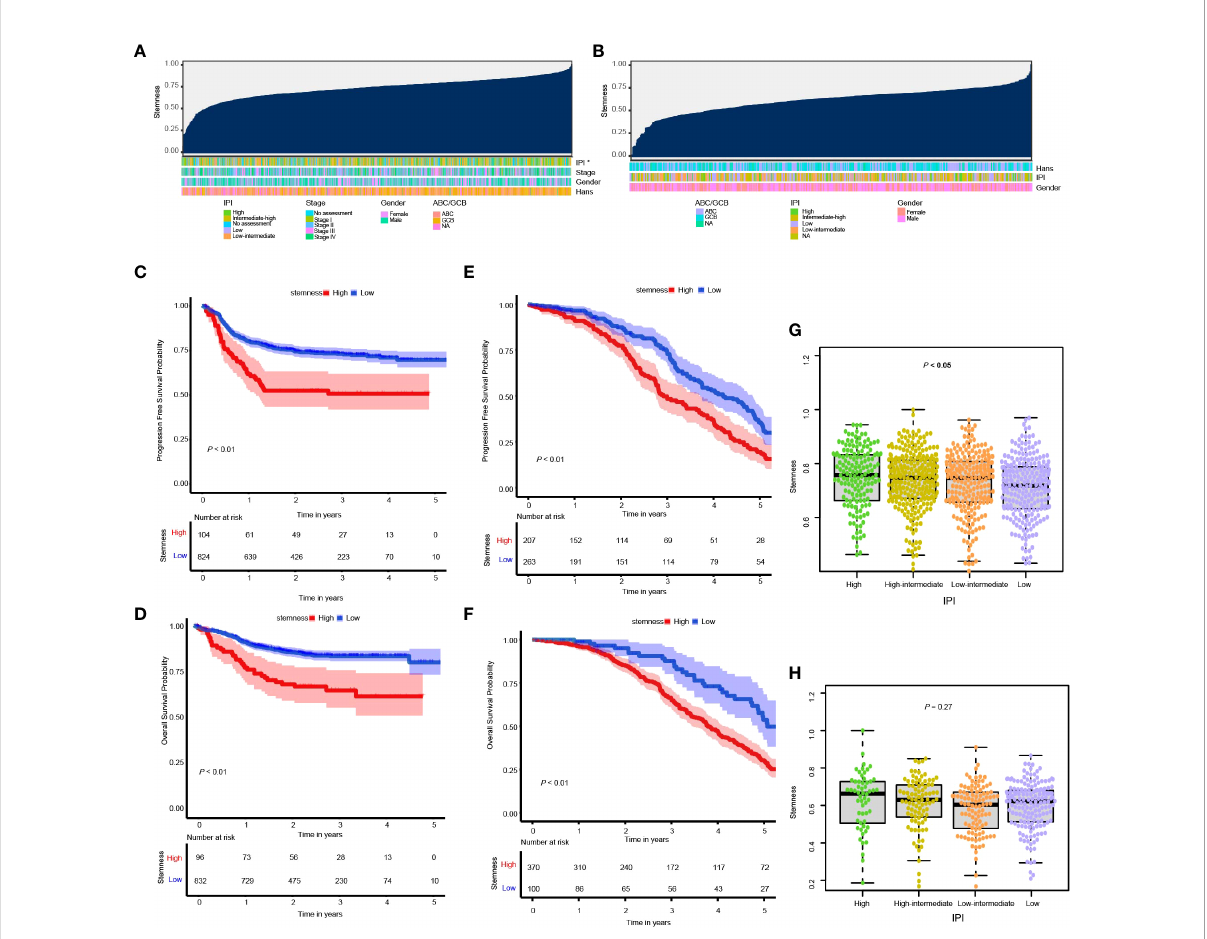
FIGURE 1 (A, B) Overview of the correlation between potential predictive co-variates and the degree of stemness in the GSE117556 and GSE31312 datasets. Columns represent samples sorted by the degree of stemness from low to high. Rows represent potential predictive co-variates; (C, D) Kaplan – Meier (K-M) analyses of PFS and survival in cohorts with low or high degrees of stemness in the GSE117556 dataset; (E, F) K-M analyses of PFS and survival in cohorts with low or high degrees of stemness in the GSE31312 datasets; (G, H) Boxplots of the degree of stemness